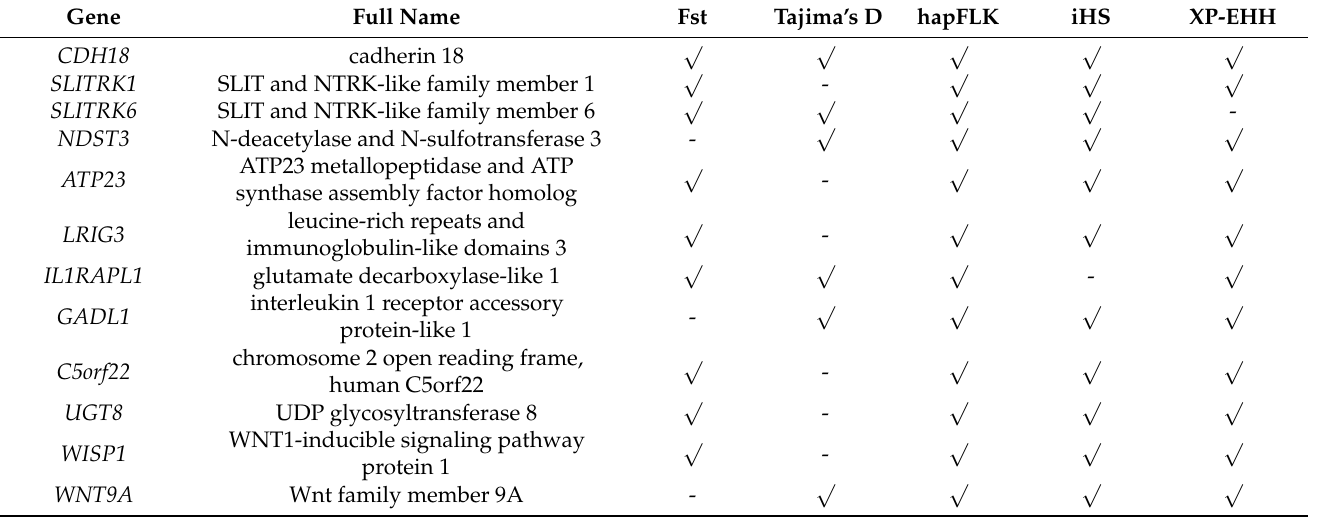
Table 2. Selective sweeps detected by four